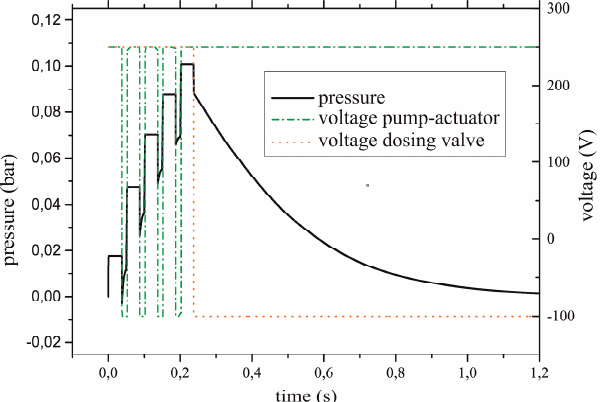
Figure 9. The voltage of the pump actuator can be seen in the green dash-dotted line and the voltage of the valve in the dotted line. The pressure in the storage chamber rises while the pump actuator is operated. After reaching a pressure of 0.1 bar the actuation of the pumps stops and the valve opens (see corresponding lines). The pressure drops with a capacitive discharge characteristic.